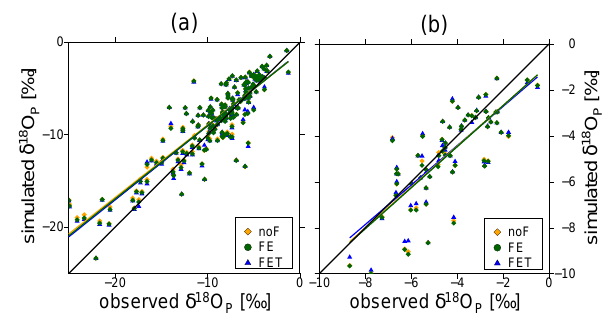
Fig. 9. Comparison of ECHAM5-JSBACH-wiso simulated and ob- Fig.9. ComparisonofECHAM5-JSBACH-wisosimulatedandobservationaldataof (cid:14) 18 O P : (a) T (cid:20) 20 ◦ C and(b) T (cid:21) 20 ◦ C . servational data of δ 18 O P : (a) T ≤ 20 ◦ C and (b) T > 20 ◦